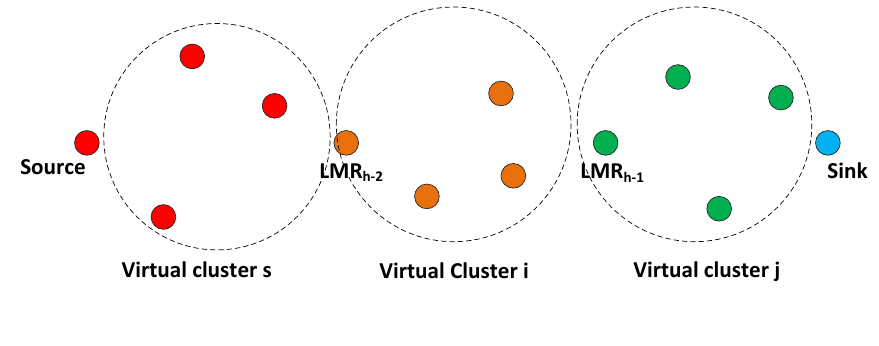
Figure 4. VCG organization after the VCG formation stage. VCG, virtual contention group; PU, primary